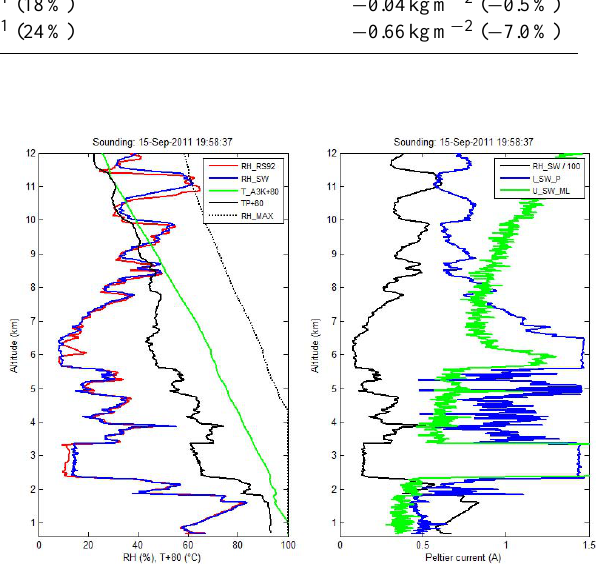
Fig. 11. Sounding on 15 September 2011 at 19:59UTC. (Left) RH measurement from RS92 (red) and Snow White (blue), and air tem- perature (green), chilled-mirror temperature (black), and saturation RH (dotted black) from Snow White. (Right) Peltier current (blue), phototransistor voltage (green), and RH (black) from Snow White. Snow White sensor was a C34/026 “night”